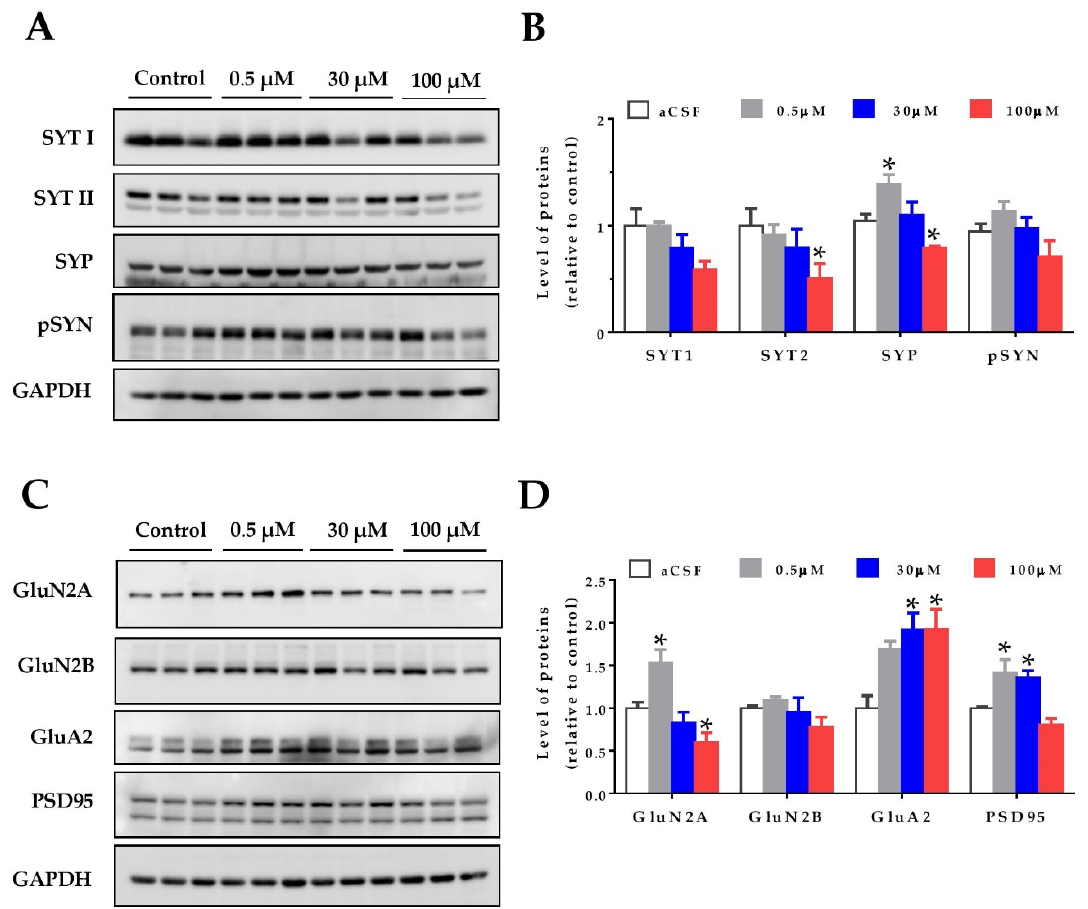
Figure 2. Homocysteine has a hormetic effect on synaptic protein levels of the hippocampus. The protein levels of hippocampal slices were evaluated after treatment with increasing concentrations of HCy (0.5, 30, and 100 µM) for 1 h. ( A ) The pre-synaptic proteins Synaptotagmin 1 (SYT1), Synaptotagmin 2 (SYT2), Synaptophysin (SYP), and phospho-Synapsin (p-SYN), were evaluated. ( B ) Densitometric analysis of (A) relative to the control condition. ( C ) Levels of post-synaptic protein NMDA receptor subunits 2A (GluN2A) and 2B (GluN2B), AMPA receptor subunit A2 (GluA2), and postsynaptic density 95 (PSD95) were evaluated. ( D ) A densitometric analysis of (C). In all cases, GAPDH was used as loading control, and protein levels were normalized against control CSF hippocampal slices. Each lane represents independent samples, n = 3. A one-way ANOVA was performed followed by a Bonferroni post-test. Bars are the mean ± SEM. * p < 0.05.